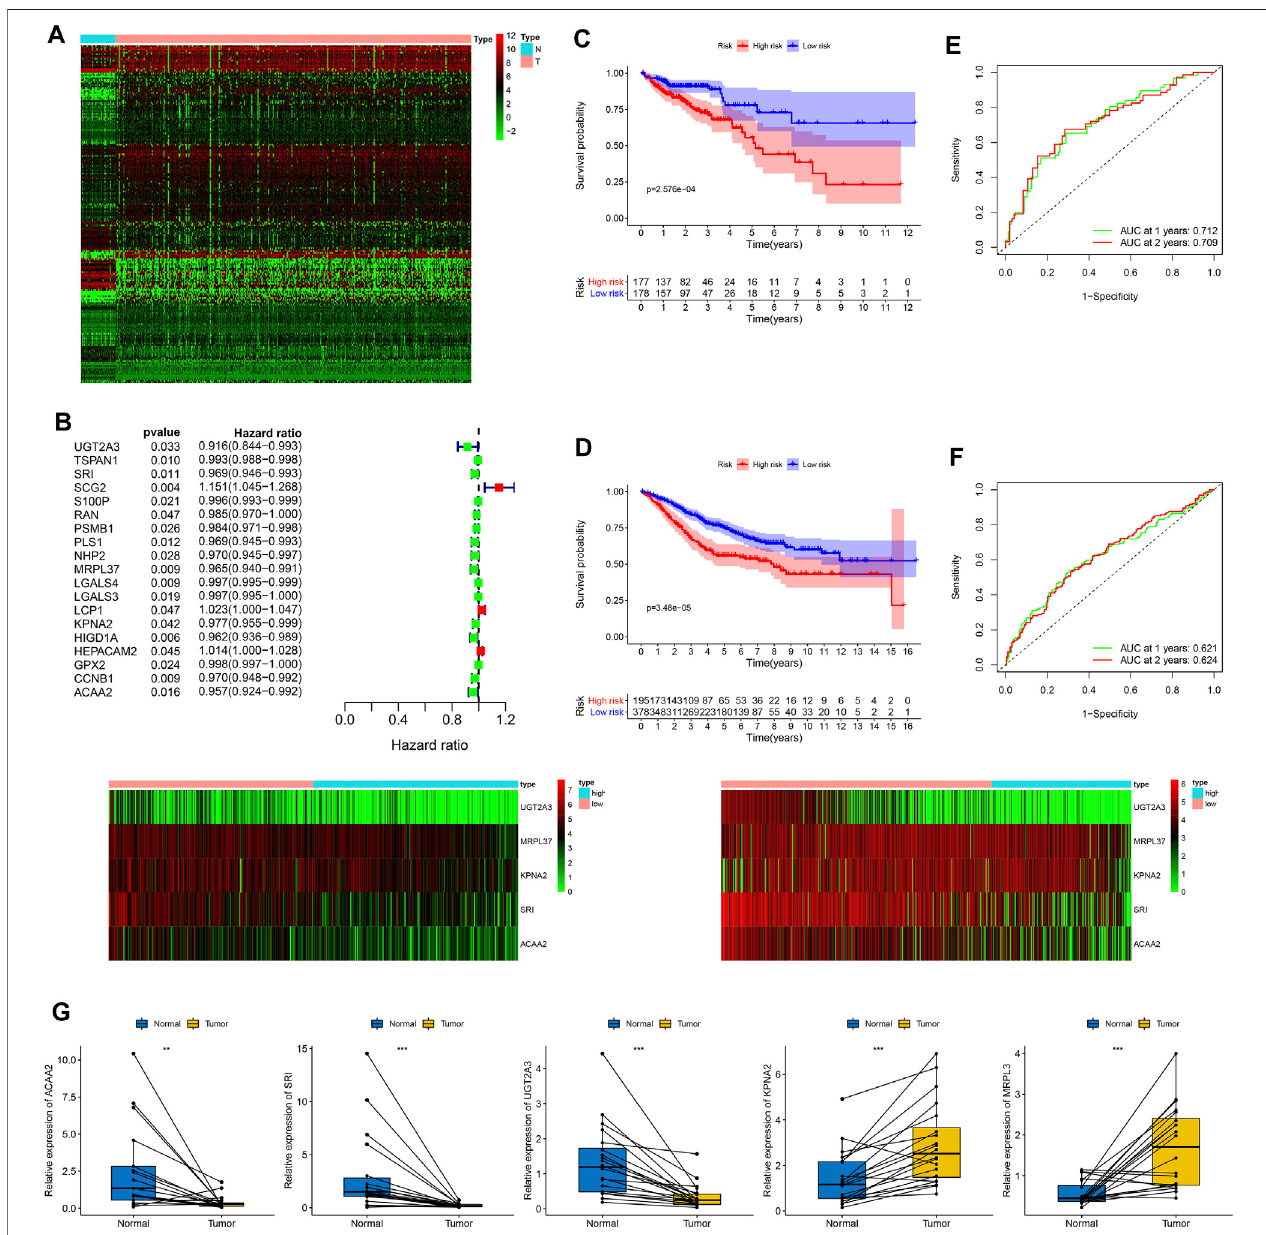
FIGURE7| GenerationofaprognosticRSsignatureandquantitativePCRforCDRGs. (A) Differentialexpressionof209CDRGsinnormaltissuesandCCsamples with|log2(FC)| > 1andFDR < 0.05. (B) UnivariateanalysisofCDRGs.Kaplan – Meieranalysisbetweenthelow-riskgroupandthehigh-riskgroupin (C) thetrainingsetand (D) thevalidation set.Thevaluesoftheareas undertheROCcurves forpredicting 3-,4-,and 5-yearOSin (E) thetrainingsetand (F) validationset. (G) QuantitativePCR for fi ve CDRGs in the RS signature. * p < 0.05; ** p < 0.01; *** p < 0.001. CC, colon cancer, CDRGs, CC differentiation-related genes, FDR, false discovery rate; OS, overall survival; ROC, receiver operating